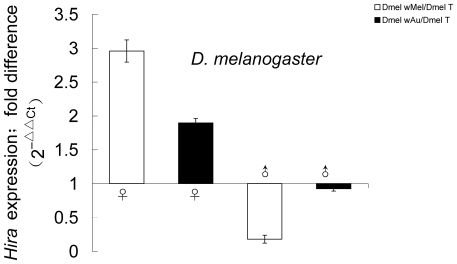

Hira gene expression in adult Drosophila melanogaster flies.Quantitative RT-PCR was performed on 1-day-old males and 3∼4-day-old females infected with the wMel and wAu strains of Wolbachia in addition to Wolbachia-uninfected flies (Dmel T). “/” represented the relative value; bars = standard error; “*” indicated P<0.05, “**” indicated P<0.01. Abbreviations: Dmel wMel, Drosophila melanogaster infected with wMel; Dmel wAu, Drosophila melanogaster infected with wAu; Dmel T, Drosophila melanogaster treated with tetracycline (without Wolbachia).